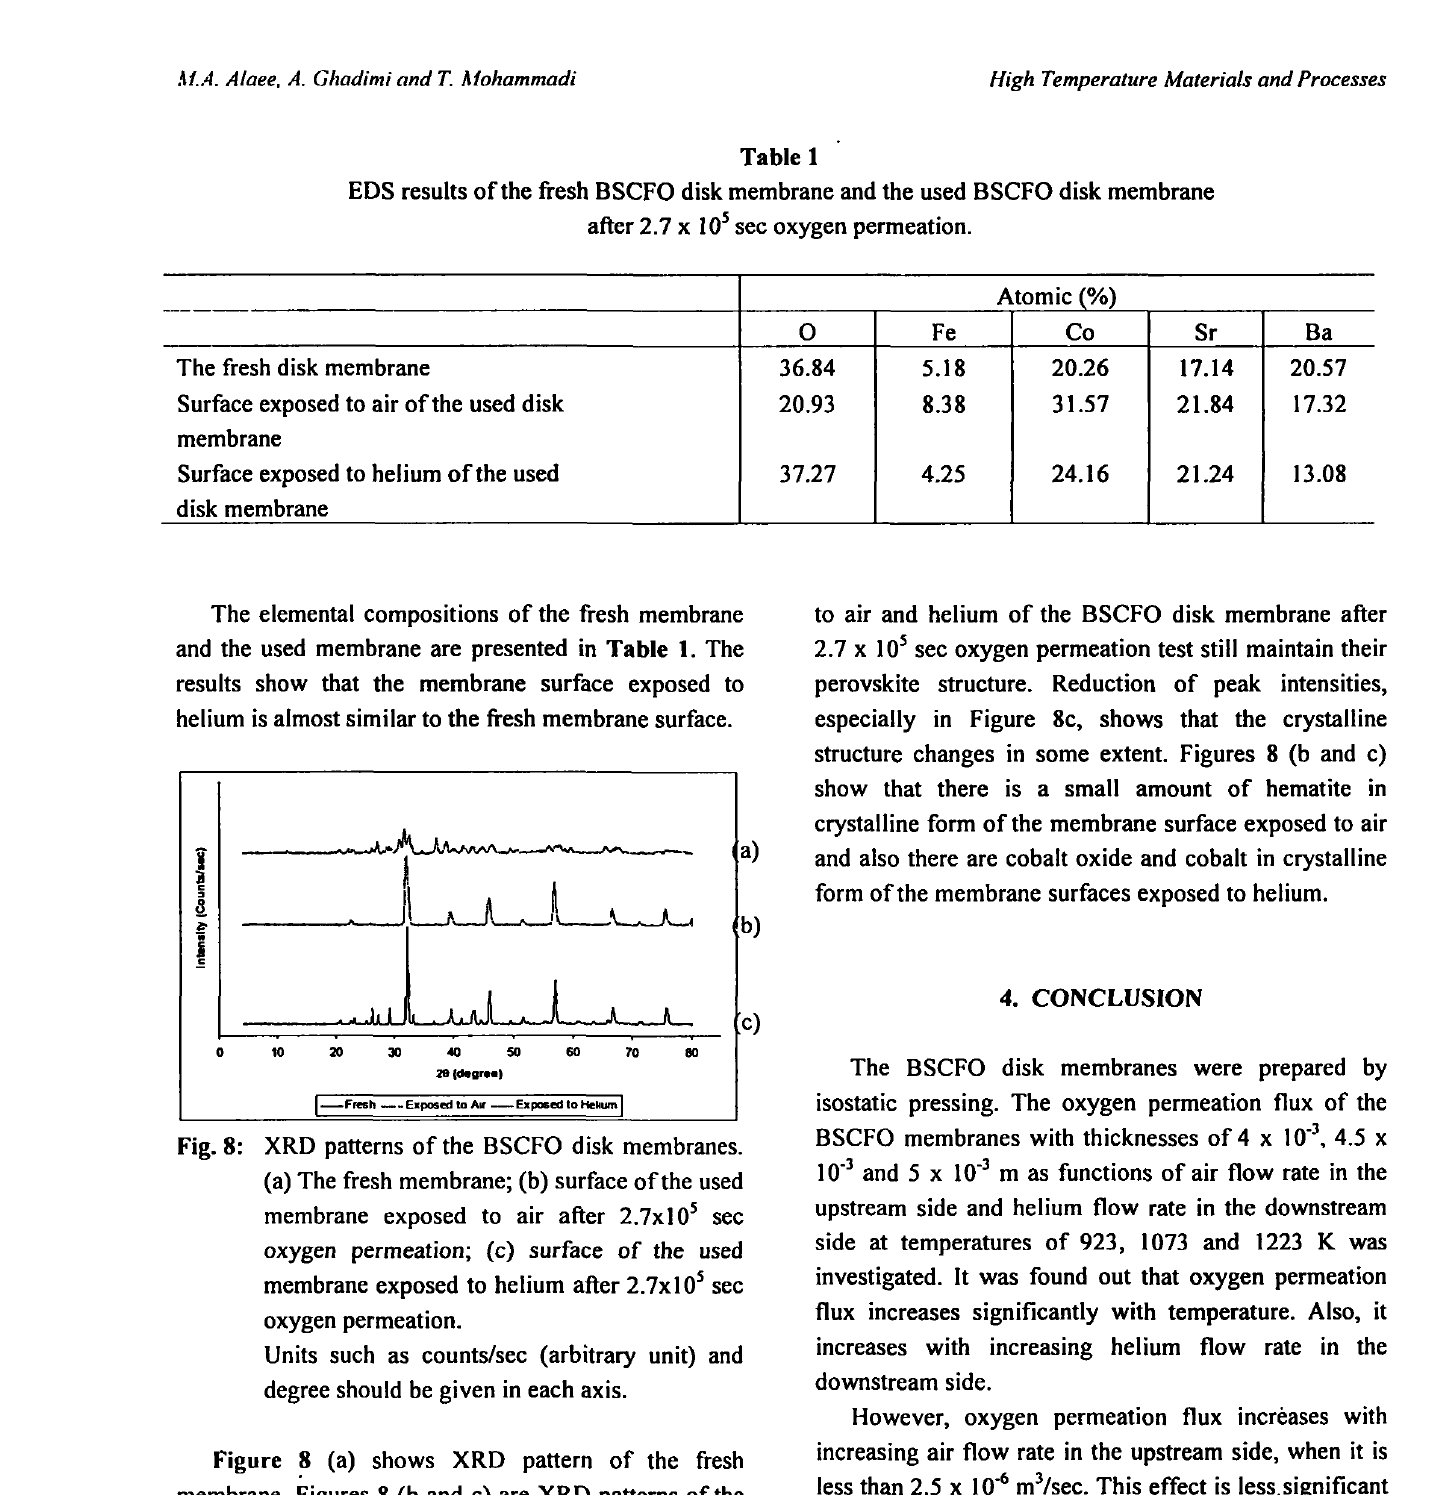
Fig. 8: XRD patterns of the BSCFO disk membranes, (a) The fresh membrane; (b) surface of the used membrane exposed to air after 2.7x10 5 sec oxygen permeation; (c) surface of the used membrane exposed to helium after 2.7x10 5 sec oxygen permeation. Units such as counts/sec (arbitrary unit) and degree should be given in each